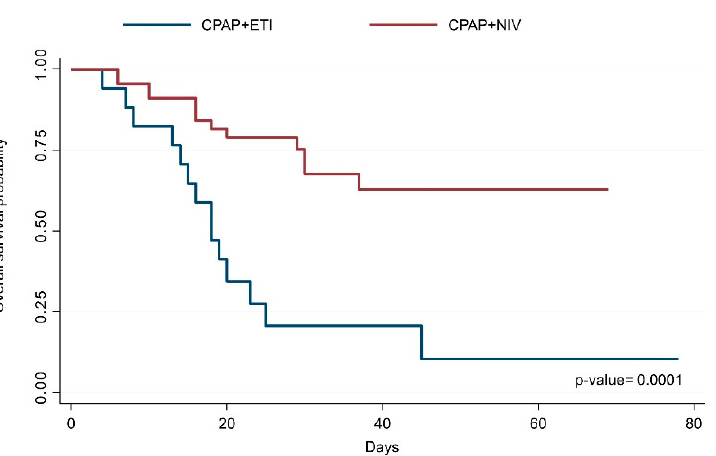
Figure 2. Probability of survival after CPAP failure in patients directly intubated and patients treated with NIV. CPAP = continuous positive airway pressure; NIV = noninvasive ventilation.